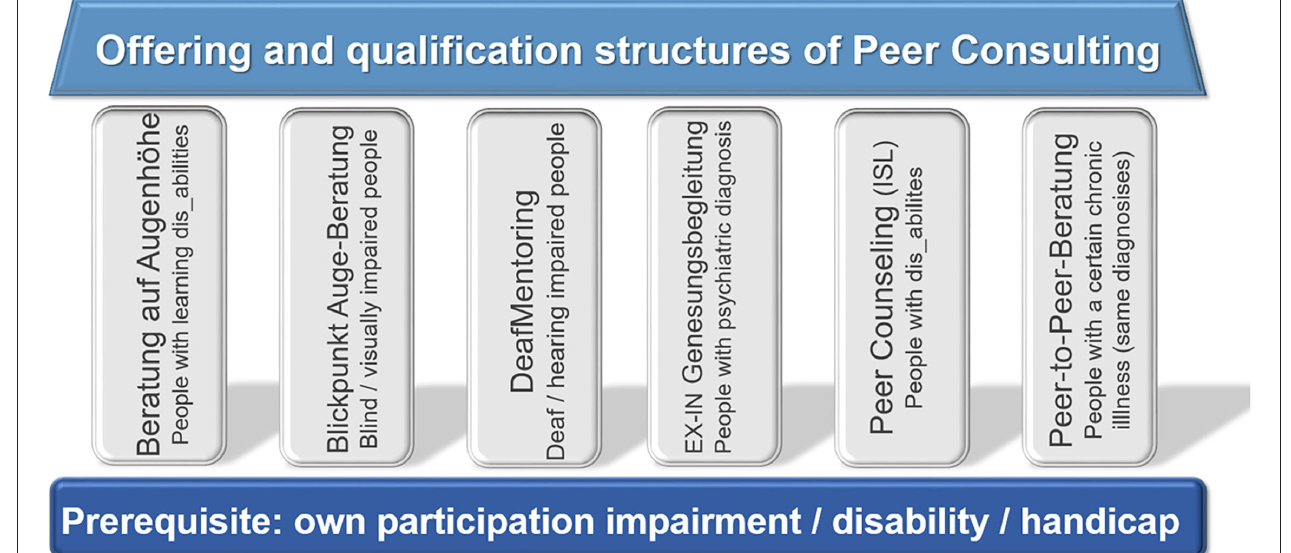
FIGURE 2 | Offering and qualification structures of Peer Consulting in Germany. Pictured is a graphic that resembles a house in its structure. At the bottom of the picture—corresponding to the foundation of a building –is a transverse bar, titled “Prerequisite: own participation impairment / disability / handicap.” Based on this, there are six pillars that carry the roof “Offering and qualification structures of Peer Consulting.” Each of these six pillars represents an approach to Peer Consulting Training: From left to right there are: “ Beratung auf Augenhöhe ”—Eyelevel Counseling by and for people with learning disabilities, “ Blickpunkt Auge-Beratung ”—Eyepoint Eye-Consulting by and for blind and/or visually impaired people, “ DeafMentoring ”—a mentoring program, by and for deaf and/or hearing impaired people, “ EX-IN-Genesungsbegleitung ”—EX-IN-Recovery-Support by and for people with psychiatric diagnosis, Peer Counseling by and for people with disabilities, “ Peer-to-Peer-Beratung ”—Peer-to-Peer-Counseling by and for people with a certain chronic illness (same